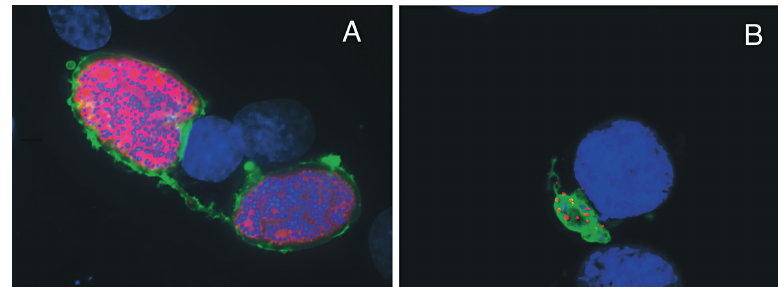
Fig. 3. – A) P. berghei -infected hepatic cell line. HepG2 cells were infected with P. berghei spo- rozoites and cultured for 48 hours. Cells were fixed and stained with anti-Exp1 antiserum, which stains the PVM and an antiserum that stains the parasite cytosol. B) T. parva- infected T cell. Infected cells grown in suspension were fixed on a slide and stained with an anti-Pim mAb, which stains the parasite membrane and an antiserum that labels host cell signalosomes localized on the surface of the